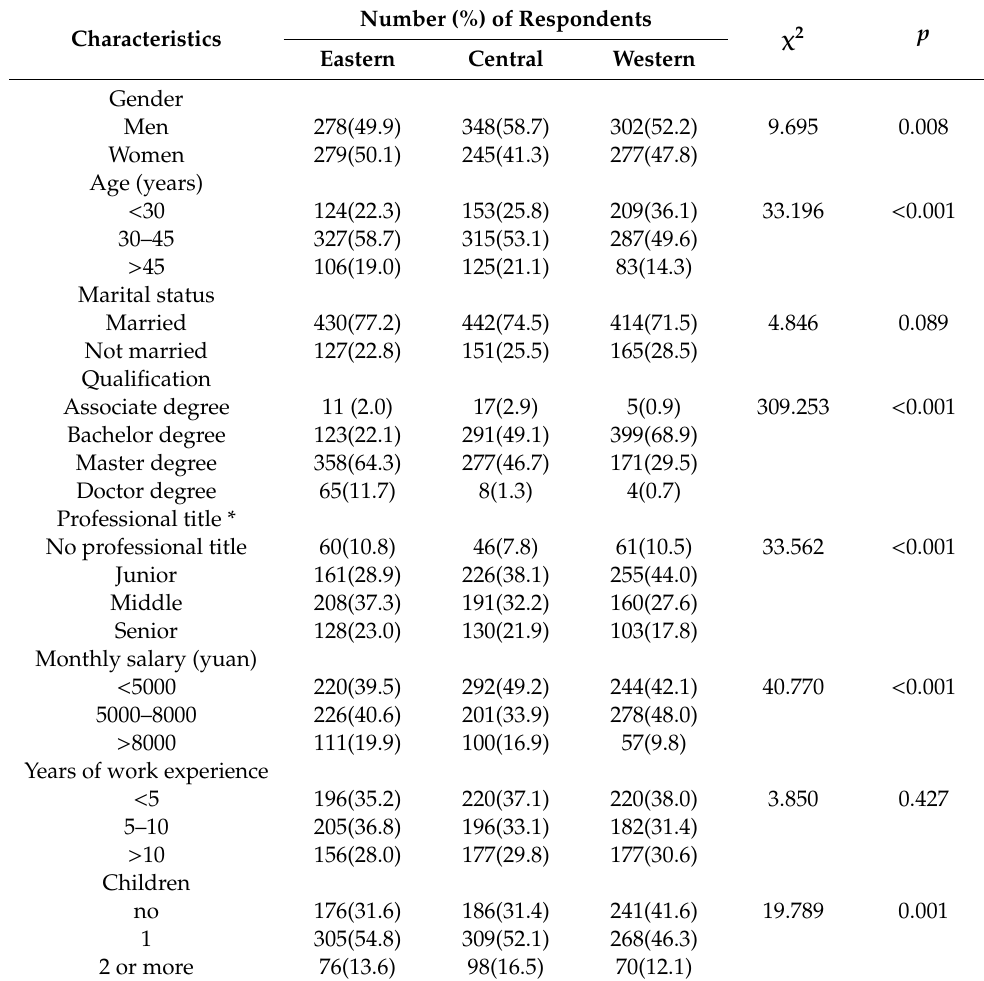
Table 3. Characteristics of respondents by